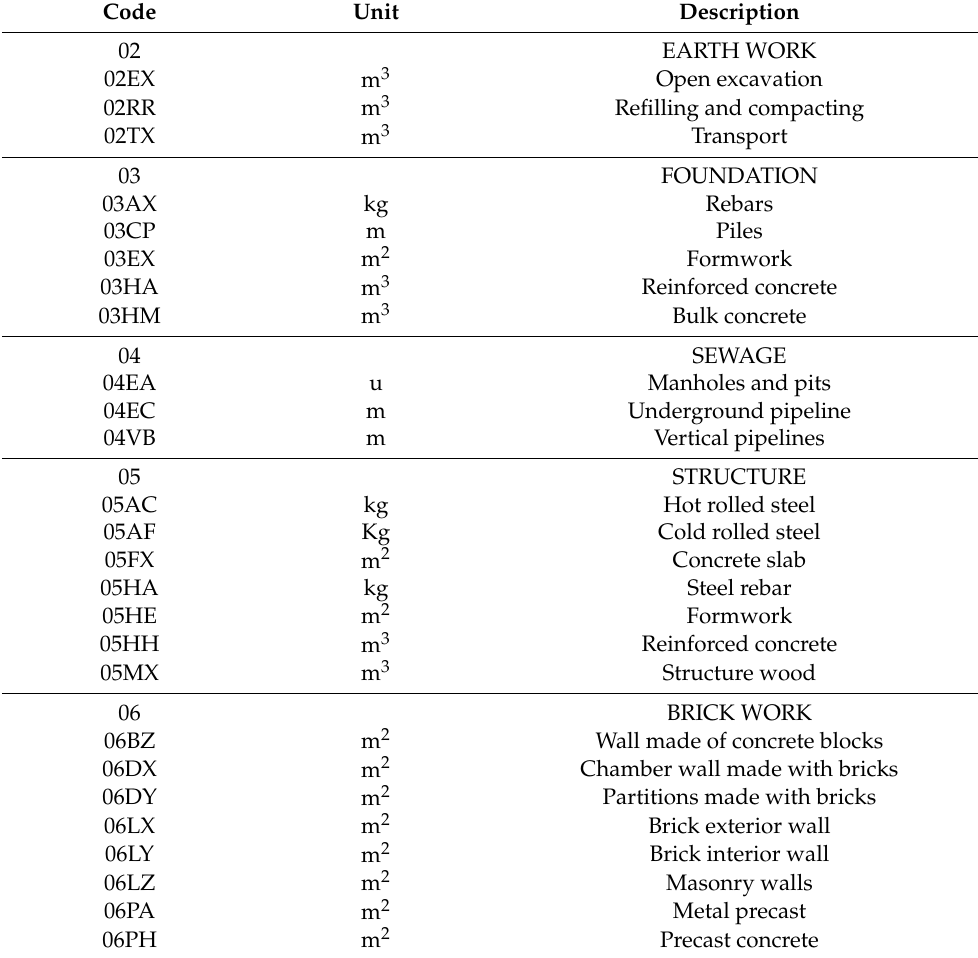
Table A1. New classification model for industrial building projects based on the